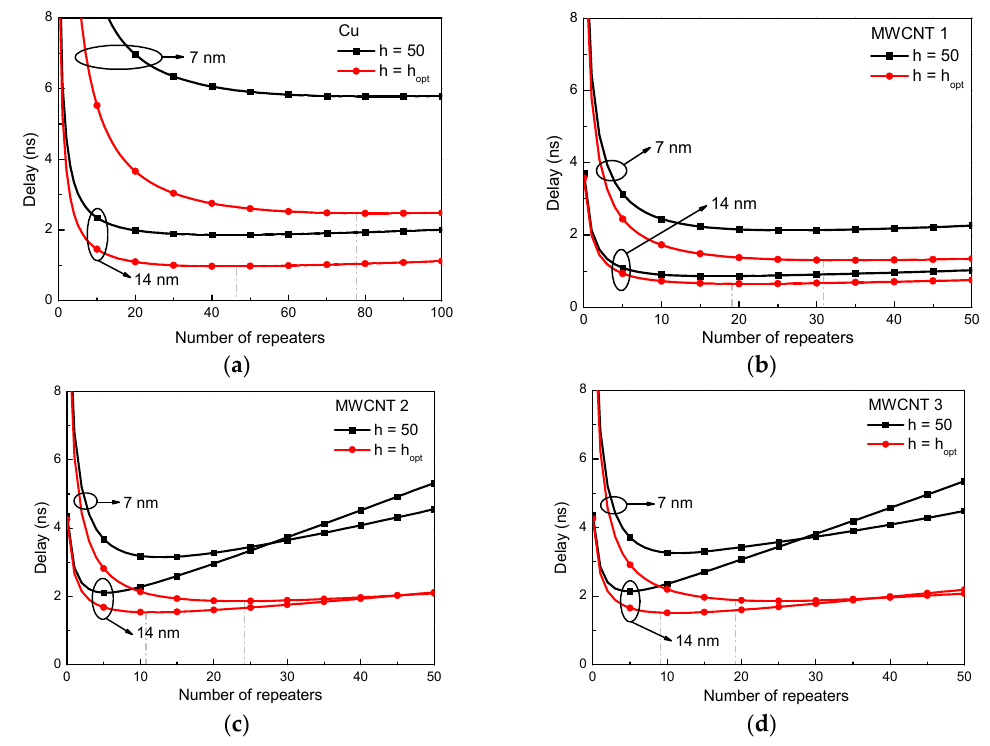
Figure 6. Propagation delays versus number of repeaters for 1000- µ m-long intermediate-level Cu and MWCNT interconnects. ( a ) Cu; ( b ) MWCNT 1; ( c ) MWCNT 2; and ( d ) MWCNT 3. Table 3. Comparison of the simulated and estimated optimal number of repeaters, repeater size, and minimum time delay in 1000 µ m-long intermediate-level Cu and MWCNT interconnects at the 14 nm and 7 nm technology